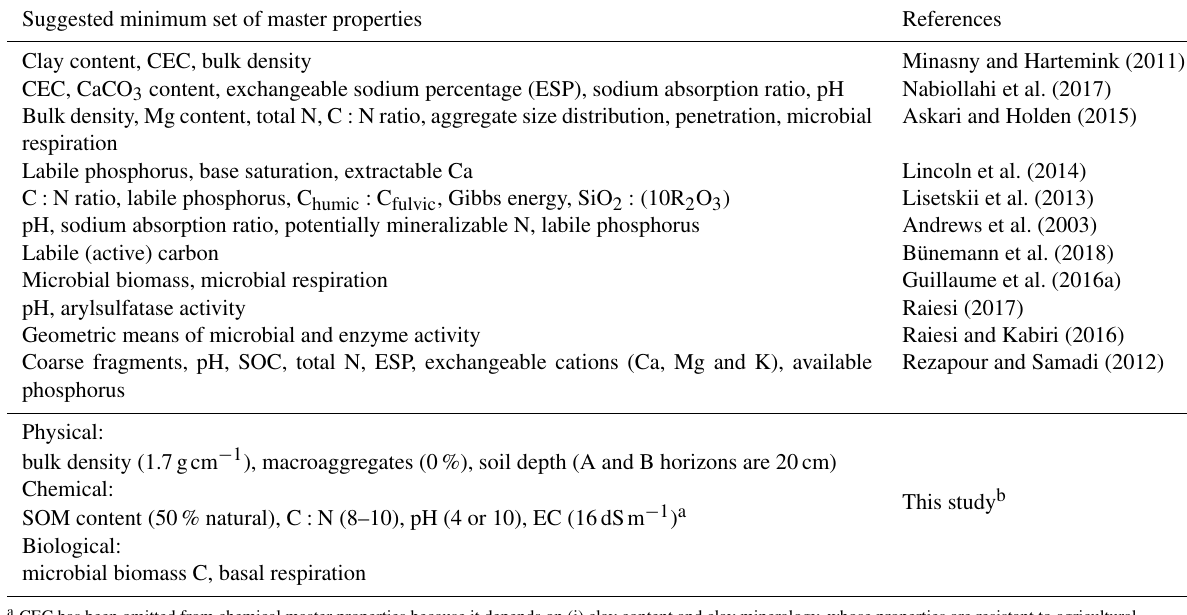
Table 3. Soil properties suggested in the literature and in agropedogenesis theory as being master properties Suggested minimum set of master